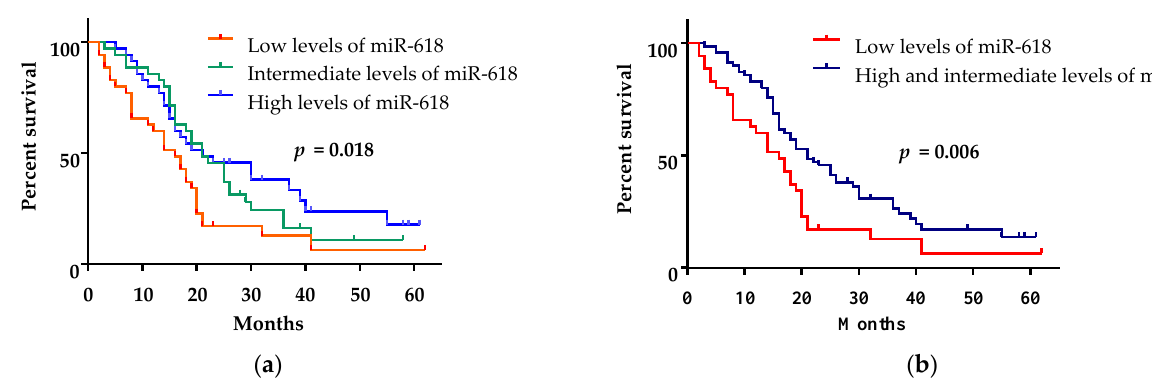
Figure 2. Kaplan–Meier survival analysis for assessment of the circulating miR-618 levels and the overall survival of mCC patients. ( a ) Overall survival of patients with high (over the 66th percentile), intermediate (between the 33th and 66th percentile) and low (up to the 33th percentile) levels of miR-618 were compared. ( b ) Overall survival of patients with high (over the 66th percentile) and intermediate (between the 33th and 66th percentile) level of miR-618 were compared to overall survival of patients with low (up to the 33th percentile) levels of miR-618. Table 2. Results of the Cox regression analysis for predicting the overall